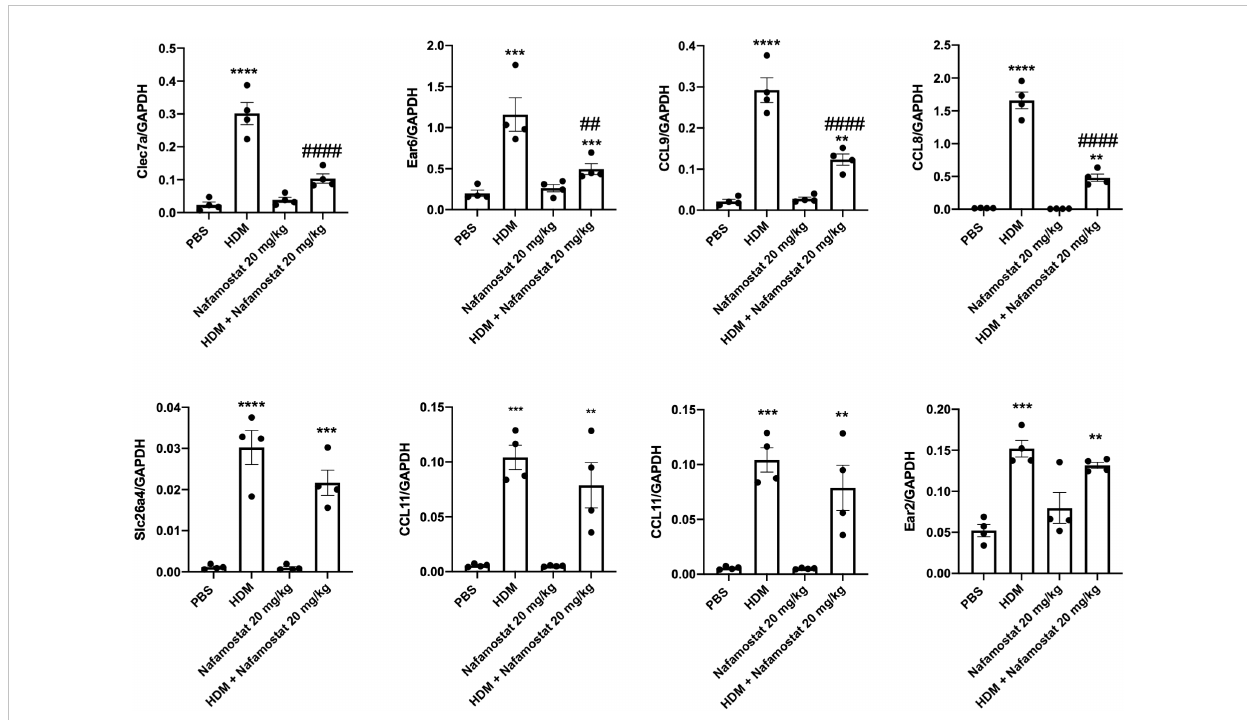
FIGURE 9 Nafamostat inhibits the expression of Dectin-1/Clec7a and chemokines in lungs of mice subjected to HDM-induced experimental asthma. Differential expression of genes in response to nafamostat was validated by qPCR analysis. The analysis included Dectin-1/Clec7a, Ear6, CCL9, CCL8, Slc26a4, CCL11, Fcer1g and Ear2. Data represent mean ± SEM. * p < 0.05, ** p < 0.01, *** p < 0.001 and **** p < 0.0001 vs. the control (PBS) group. ## P < 0.01, ### P < 0.001 and #### P < 0.0001 vs. the HDM group. n = 4 mice per group. HDM, house dust